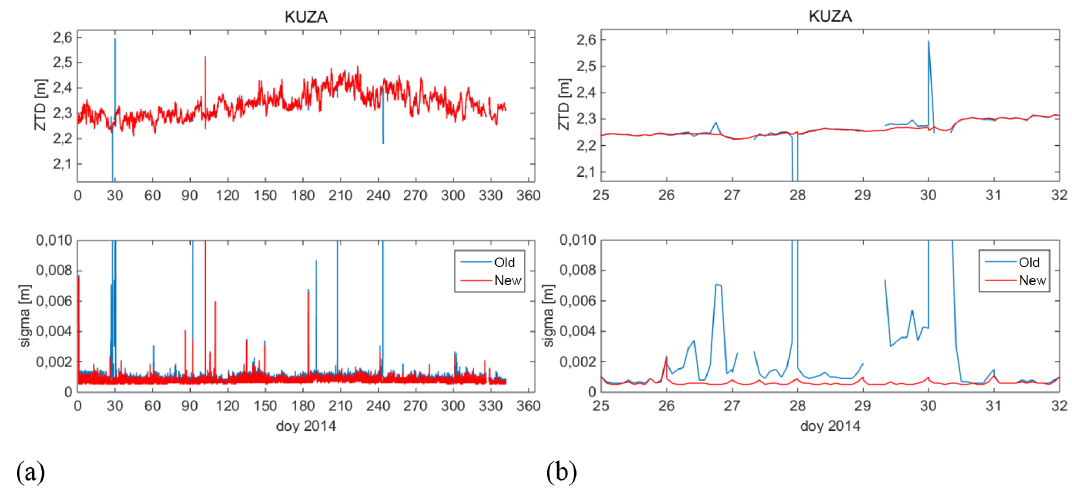
Figure 8. Similar to Fig. 7 for station KUZA. (a) Full time series. (b) Zoom-in on a period when the reference station ZYWI has many observation gaps, which cause outliers in old solution. In the new solution station KUZA is not